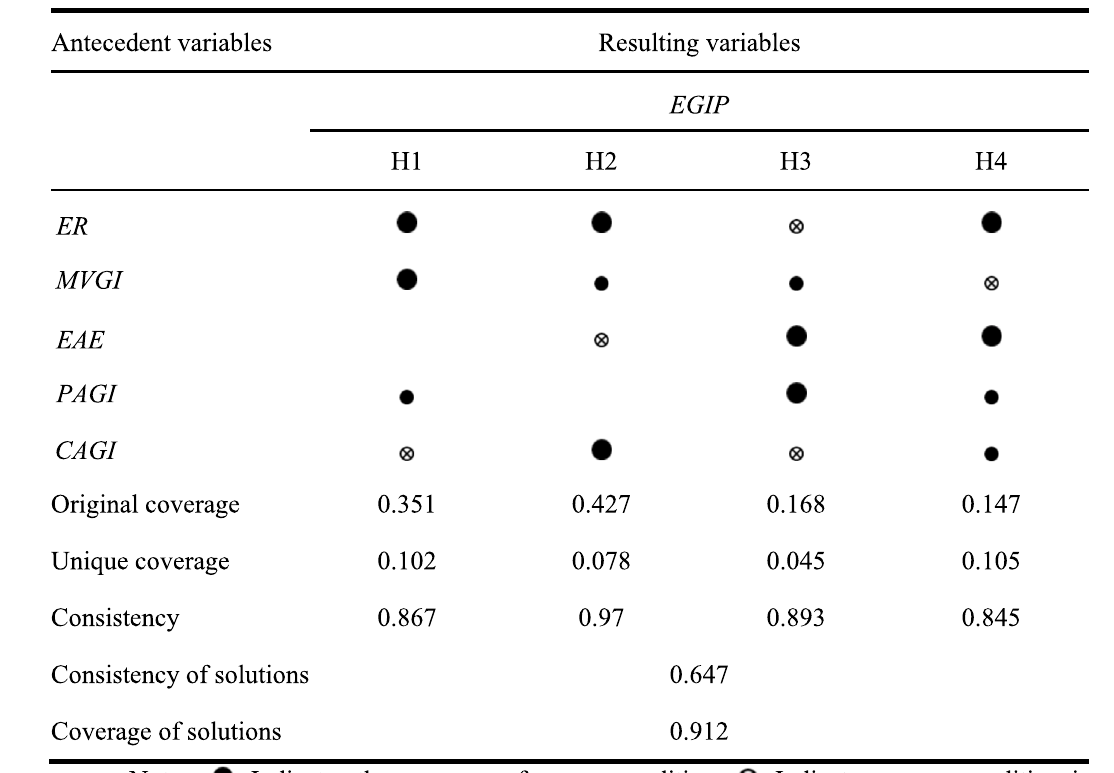
TABLE 4 Enterprise green innovation performance realization Con fi